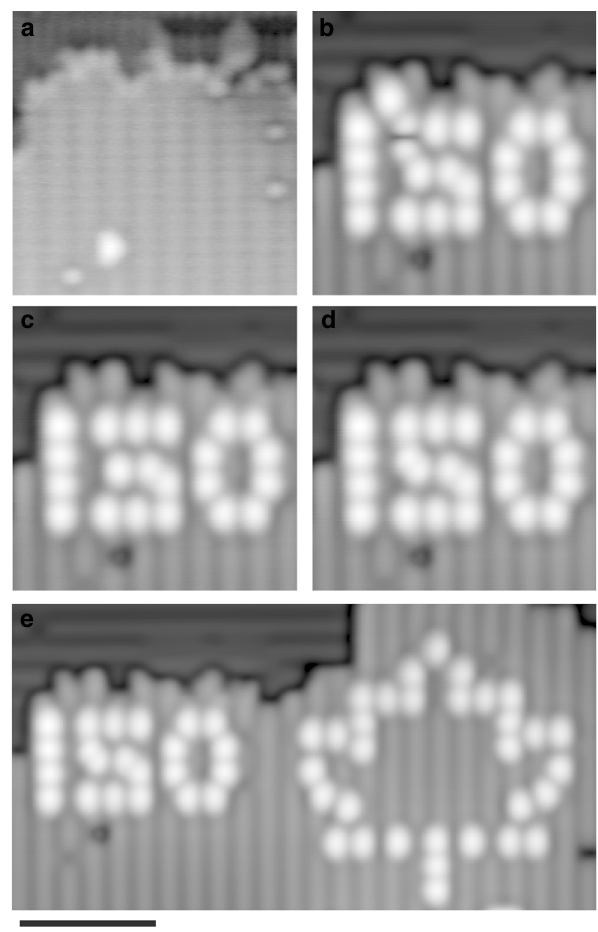
Fig. 2 Fabrication and correction on hydrogen-terminated Si(100)-2×1 via hydrogen lithography and hydrogen repassivation. a ( V = 1.4V, I = 50pA, T = 4.5K, 10×10nm 2 ) Scanning tunneling microscope image of the fabrication area used to determine the location of each hydrogen atom through Fourier image analysis. b ( V = − 1.7V, I = 50pA, T = 4.5K, 10×10nm 2 ) Fabrication of the characters “ 150 ” using hydrogen lithography (HL), one atom has been removed in error above the characters and one atom is incorrectly placed inside the “ 5 ” . The created dangling bonds (DBs) appear as bright protrusions. c , d Using the hydrogen repassivation technique, the errors were subsequently erased, then the correct hydrogen atoms were removed with HL to create an error-free structure. e ( V = − 1.7 V, I = 50pA, T = 4.5K, 11× 21nm 2 ) The completed structure of 54 DBs, depicting the characters “ 150 ” and a maple leaf. Scale bar,